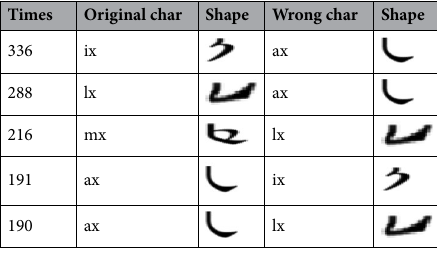
Table 10. Statistics of replace